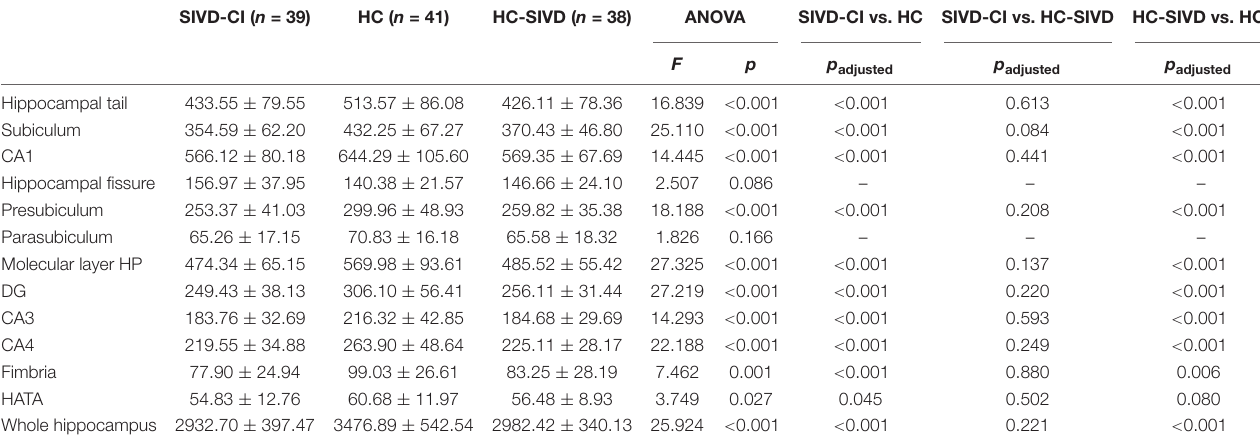
TABLE 4 | Analysis of covariance of the volumes of left hippocampal subfields among the three groups. SIVD-CI ( n = 39) HC ( n = 41) HC-SIVD ( n =